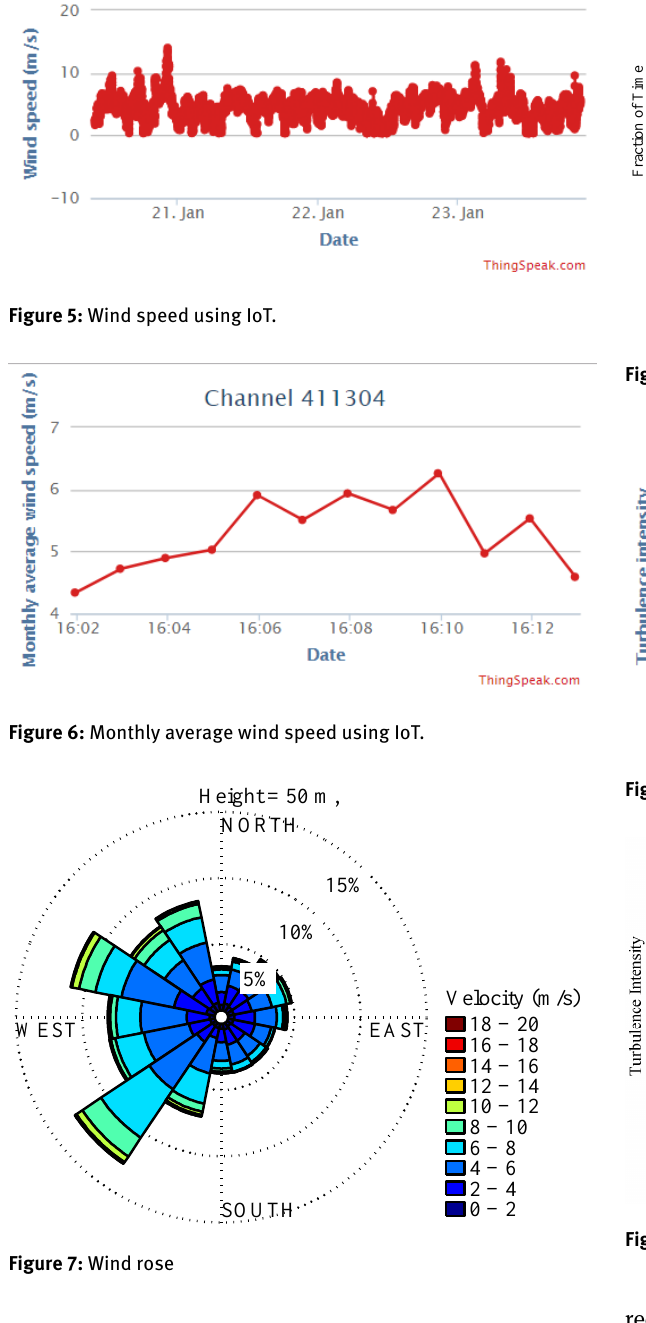
dicting components failures, and optimize maintenance schedules, which will drive down the cost of operating wind turbines.